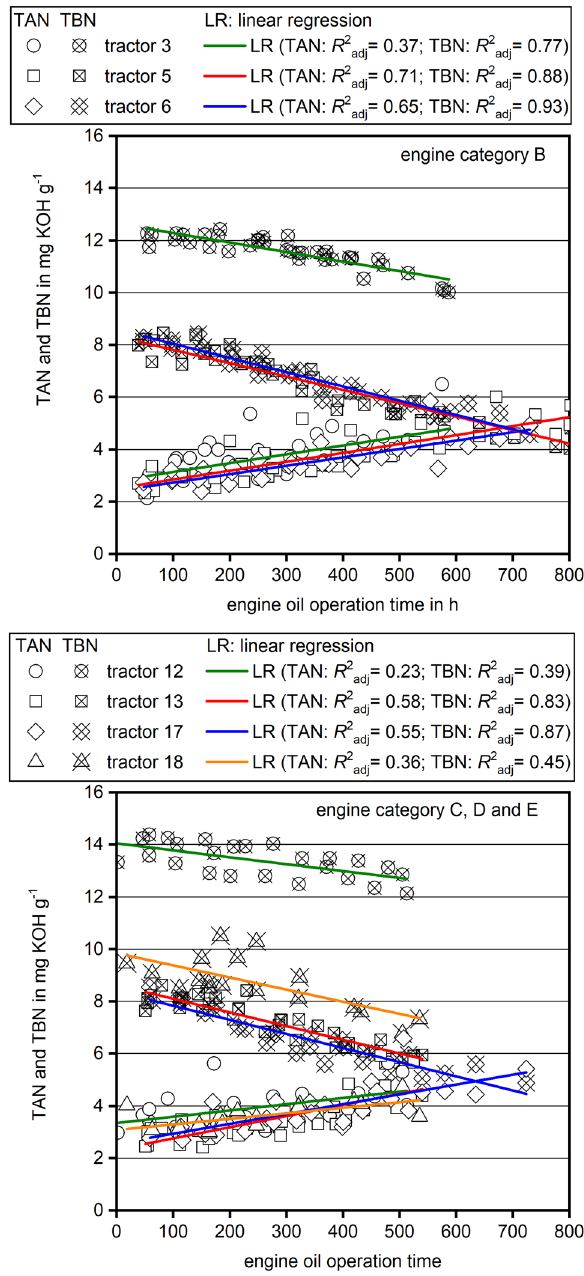
Fig. 4 Total acid number (TAN) and total base number (TBN) of the engine oil in relation to the engine oil operation time for different tractors in the defined tractor